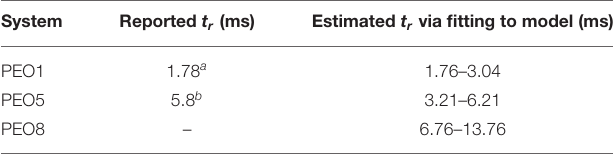
TABLE 1 | Comparison between reported values in the literature of viscoelastic relaxation time and the range estimated by the theoretical model via the experimental